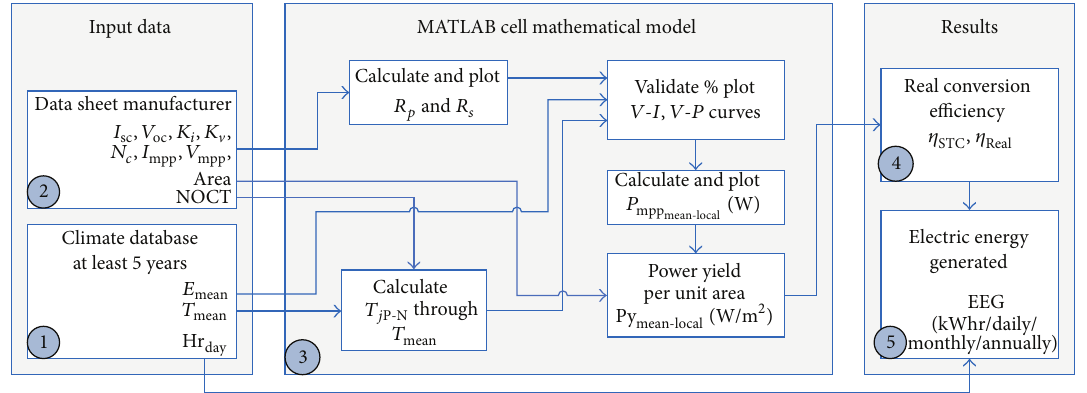
Figure 1: Proposed method